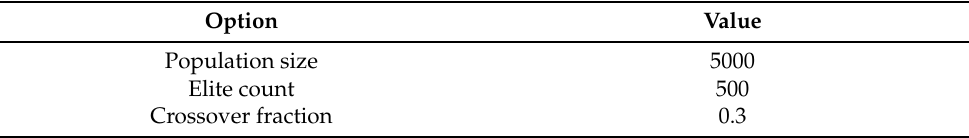
Table 4. Settings for the Genetic